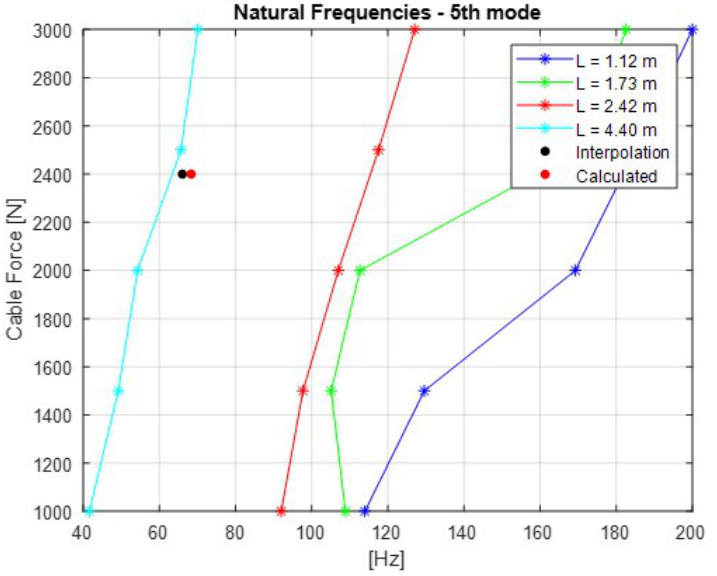
Figure 11. Relationship between the cable force and natural frequencies for the fifth mode of